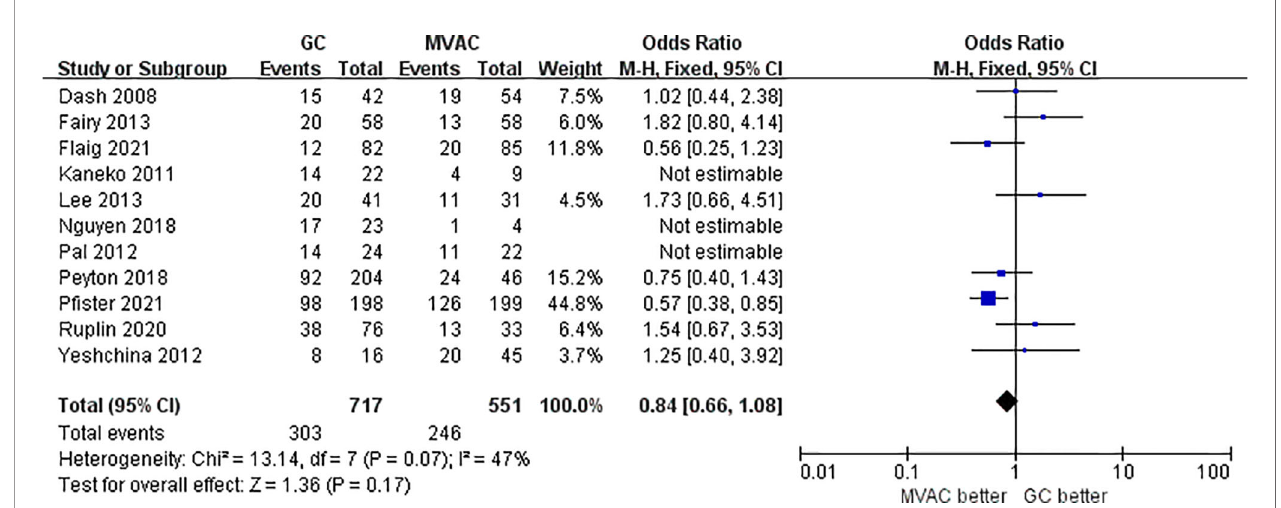
FIGURE 6 | Forest plot of pathological partial response (PPR) to GC versus MVAC after removing studies with small sample